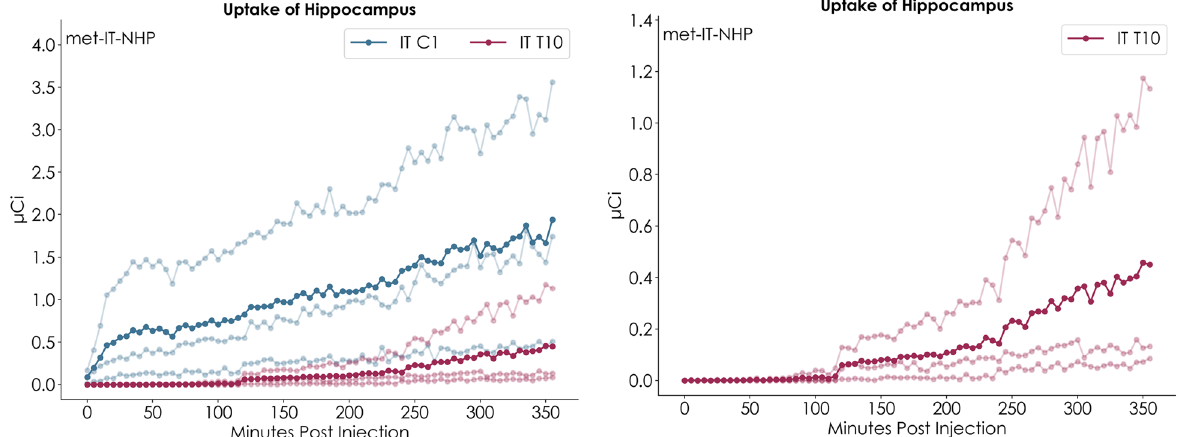
Fig. 1 Time activity curves for the hippocampus. The left plot has data for both catheter tip at C1 (blue) and catheter tip at T10 (red). The darker color represents the mean of the 3 subjects each represented by the lighter color. The right plot presents the data for catheter tip at T10 only, with a different y-axis scale, highlighting some individual animal variation in